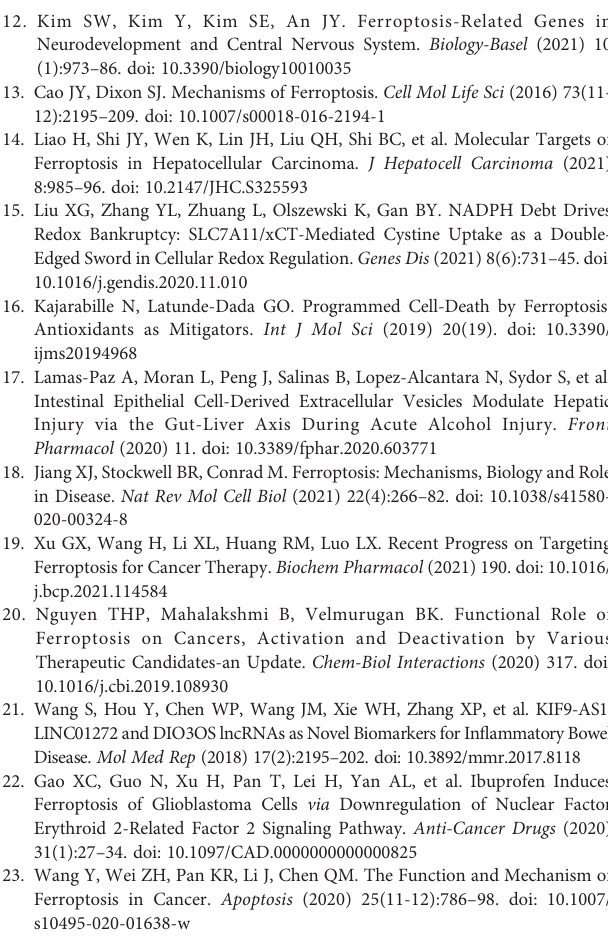
and CD44 when PELATON was knocked down or overexpressed in glioblastoma cells, Datas were mean ± SEM for three independent experiments. (*p < 0.05, ***p < 0.001, ns: not signi fi cant). (H – I) Protein level changes of BACH1 , CD44 and P53 when PELATON was knocked down or overexpressed in glioblastoma cells, independent experiment was repeated for three times. Supplementary Figure 4 | Regulatory Relationship between PELATON and P53 . (A) Bioinformatics correlation between PELATON and P53 . (B) The difference in PELATON expression between wild-type and mutant P53 in GBM patients. (C) western blot analysis of BACH1 , CD44 and P53 when PELATON and P53 were overexpressed in glioblastoma cells, independent experiment was repeated for three times. Supplementary Figure 5 | Association of PELATON expression between patient prognosis and GBM cell phenotype. (A) RT-qPCR analysis of PELATON in glioma primary cells (PG-1, PG-2, PG-3, PA-1, PA-2, PA-3) and glioma cell lines (U118, U251). PG-1, PG-2, and PG-3 are primary cells from patients with glioblastoma, and PA-1, PA-2, and PA-3 are primary cells from patients with astrocytoma. Datas were mean ± SEM for three independent experiments. Kaplan – Meier curves showing overall survival (B) and disease-free survival (C) of patients with GBM strati fi ed based on PELATON expression levels (p <0.05 p.adjust<0.25). (D) The effect of PELATON overexpression or knockdown on the invasion ability of glioblastoma cells (left), independent experiment was repeated for three times. (E) Migration ability of PG-3 and U251 cells after interference or overexpression with PELATON . Photos were taken at 0, 24, 48 and 72 hours, independent experiment was repeated for three